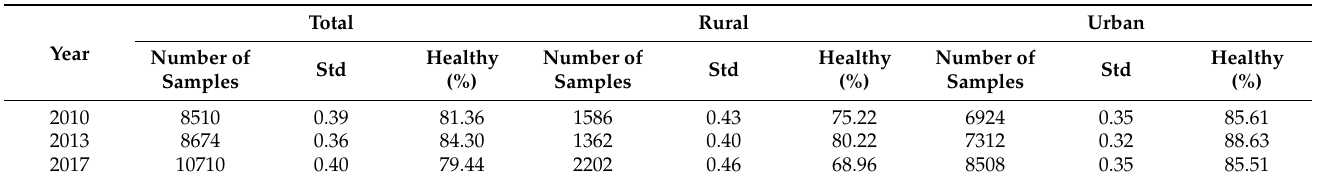
Table 3. The overall change of SRHS